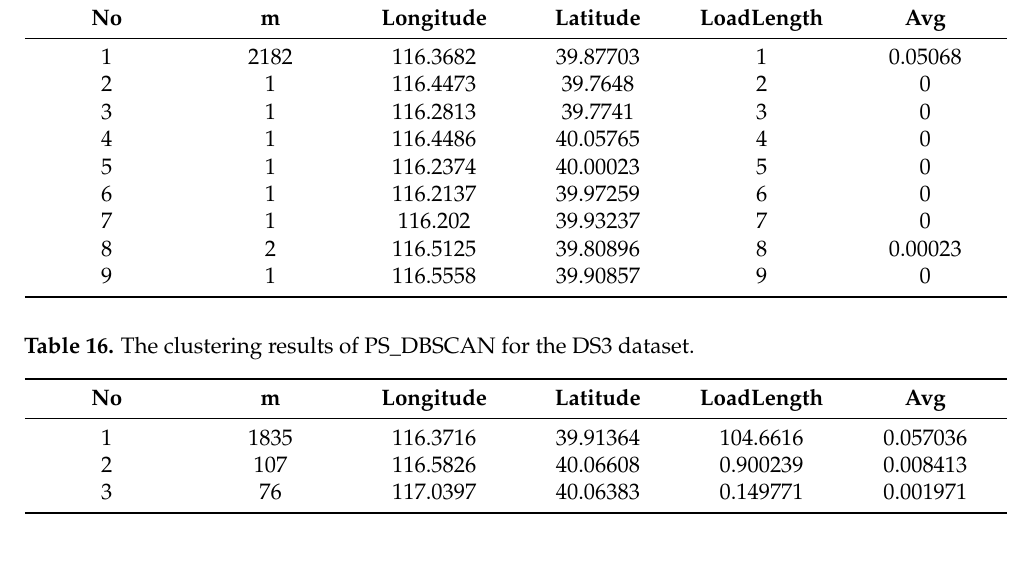
Table 15. The clustering results of HF_DBSCAN for the DS3 dataset.